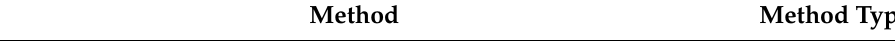
Table 4. Candidate Prediction Methods.